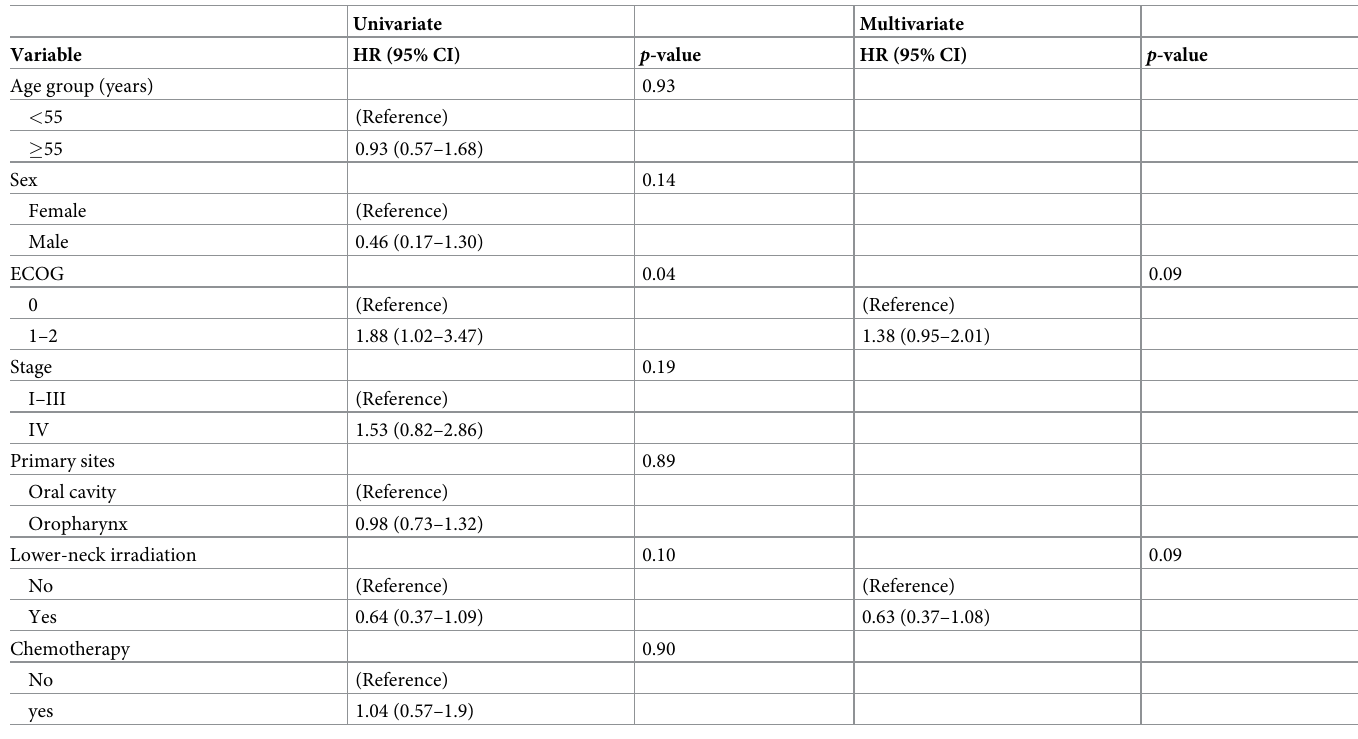
Table 5. Univariate and multivariate Cox regression analyses of disease-free survival. Univariate